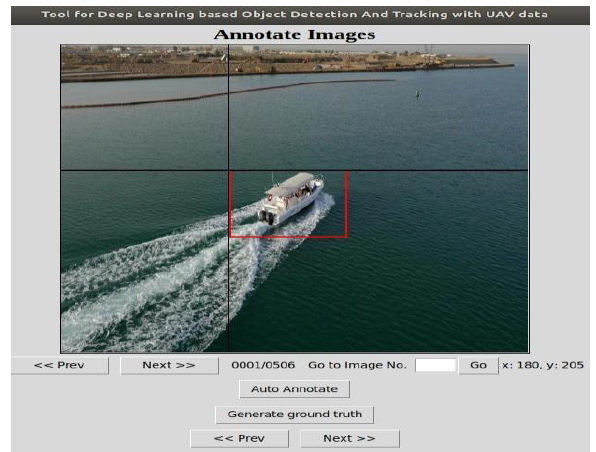
Figure 6. Single object